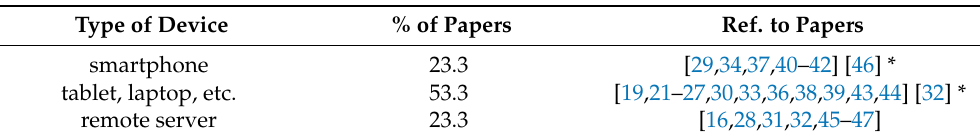
Table 3. Devices used for data processing. In some papers (mentioned with a “*”), a hybrid client–server architecture was used (smartphone/laptop + remote server).